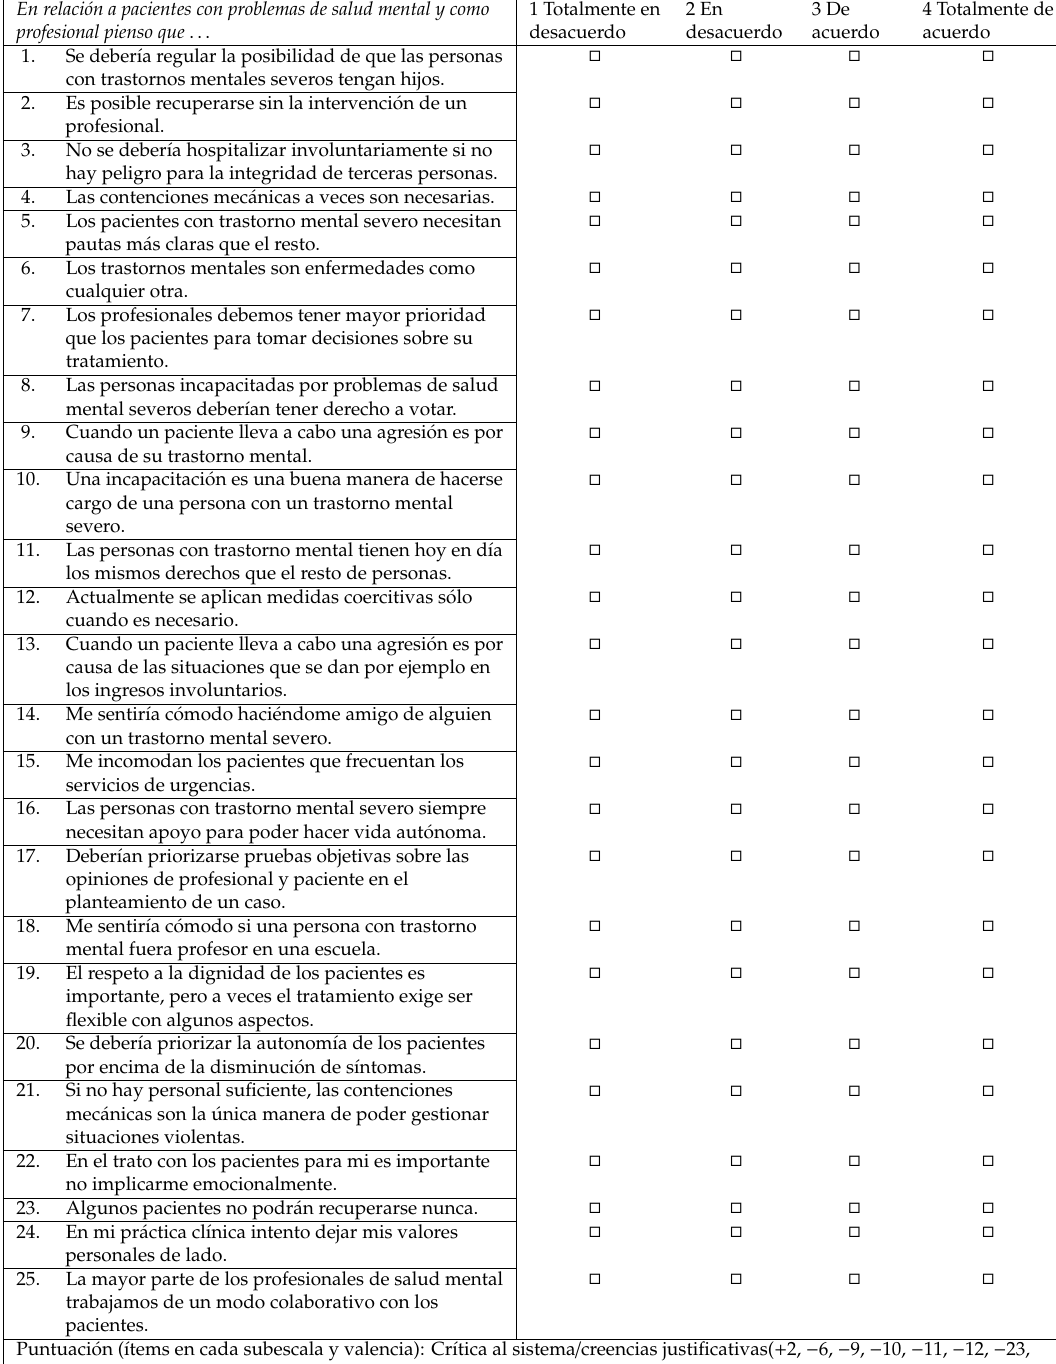
Table 4. Spanish Version of the Beliefs and Attitudes towards Mental Health Service Users’ Rights Scale including scoring